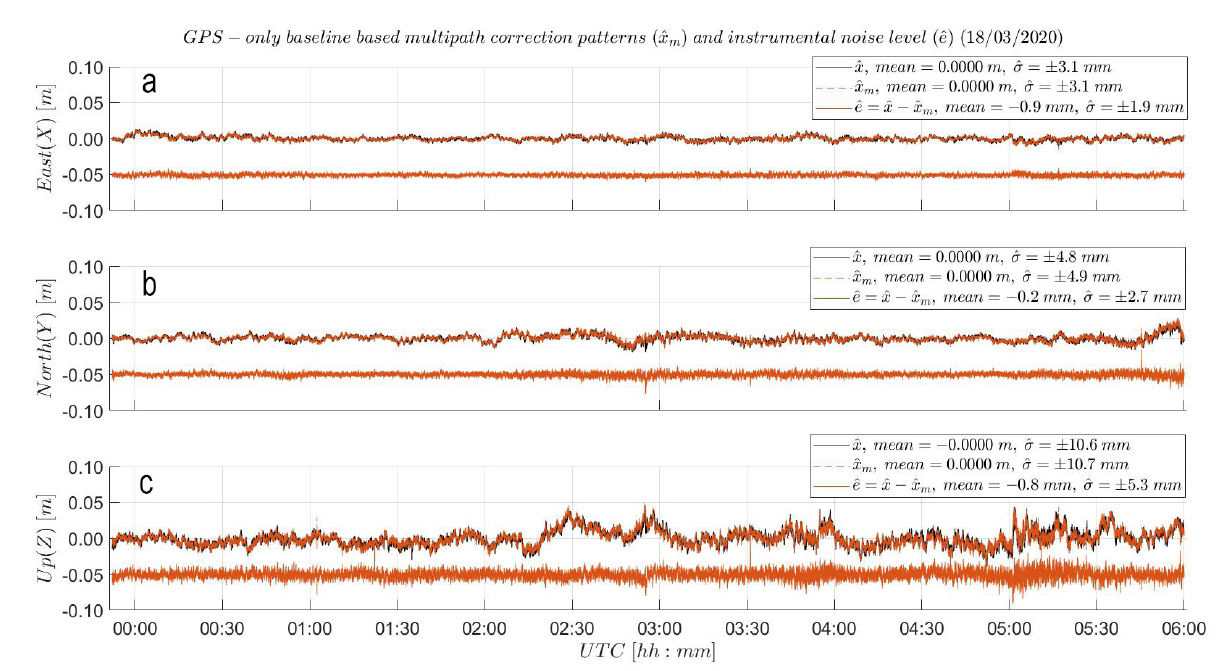
Figure A5. ( a ) East, ( b ) North and ( c ) Up baseline-based MP correction ( ˆ x m , black curves) of a six-hour fragment of the baseline time series of day 078 (bright red) and the resulting GNSS empirical noise (ˆ e ) level (red) post subtraction of the baseline based time series. For visualization purposes, the ENU noise sequences are shifted with 5 cm. Resulting ENU instrumental noise time series are showing a better variability (ˆ σ ) than in Figure A4 of ± 1.9, 2.7 and 5.3 mm, respectively. The noise sequences present an even more random behavior than in Figure A4, concluding a higher effectiveness of the baseline-based correction at reducing MP. The start and end is corresponding to 18 March 2020 23:52:08 and 06:00